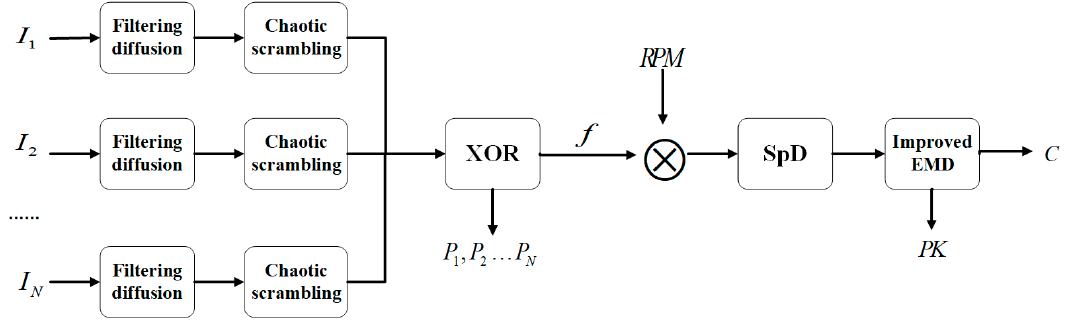
Figure 3. Process of encryption.